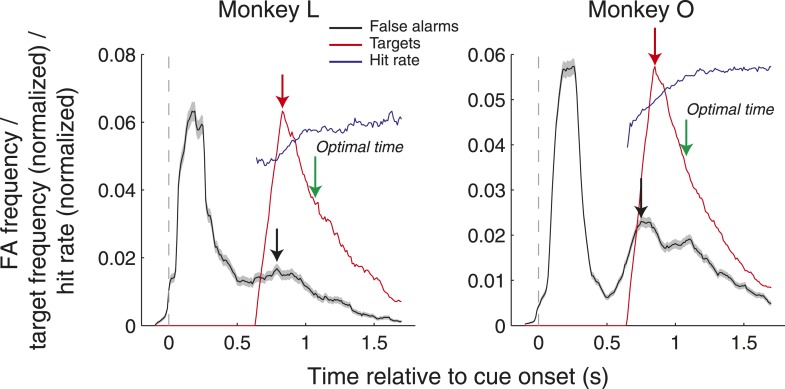
False alarm frequency (black), target onset frequency (red, normalized), and hit rate (blue, normalized) as a function of time relative to cue onset. Black and red arrows indicate the peaks of the false alarm and target onset frequency, and green arrows indicate the optimal time to saccade that would maximize hit rate. All data was computed in 200 ms windows stepped by 10 ms.